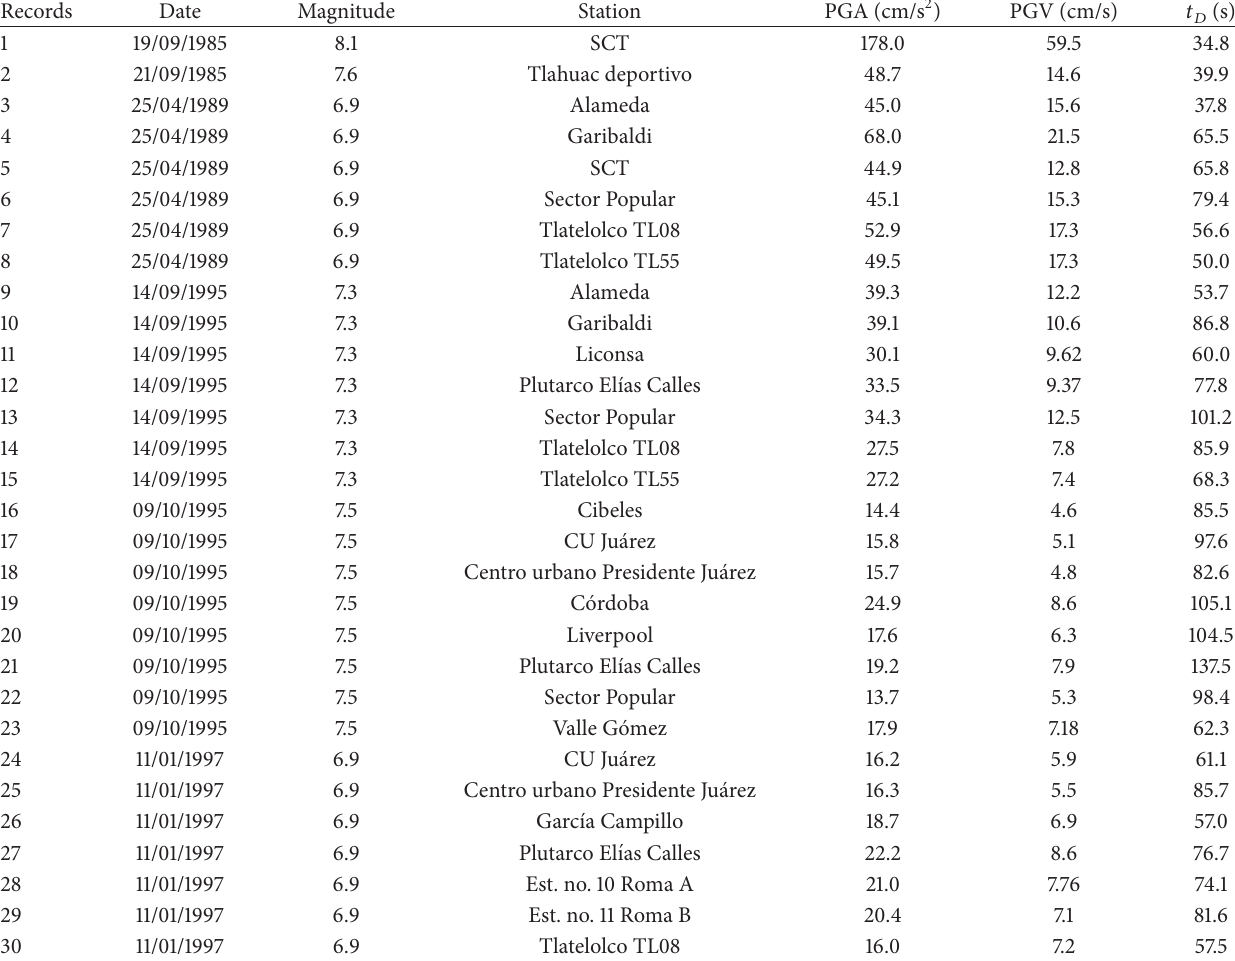
Table 2: Selected long-duration narrow-band ground motions.